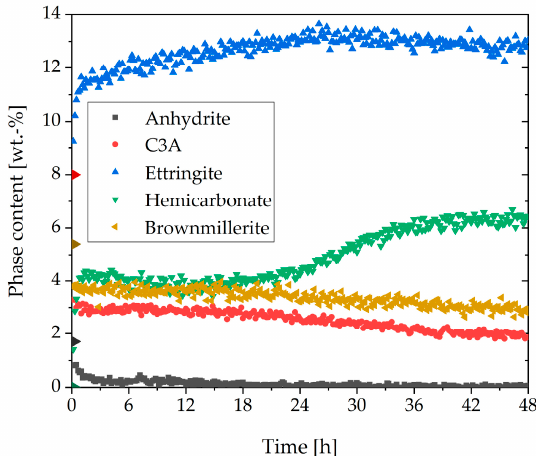
Figure 6. Phase development of the aluminum-containing phases of CEM I with direct addition of 0.7 wt% of SP during 48 h of hydration (w/c = 0.36).